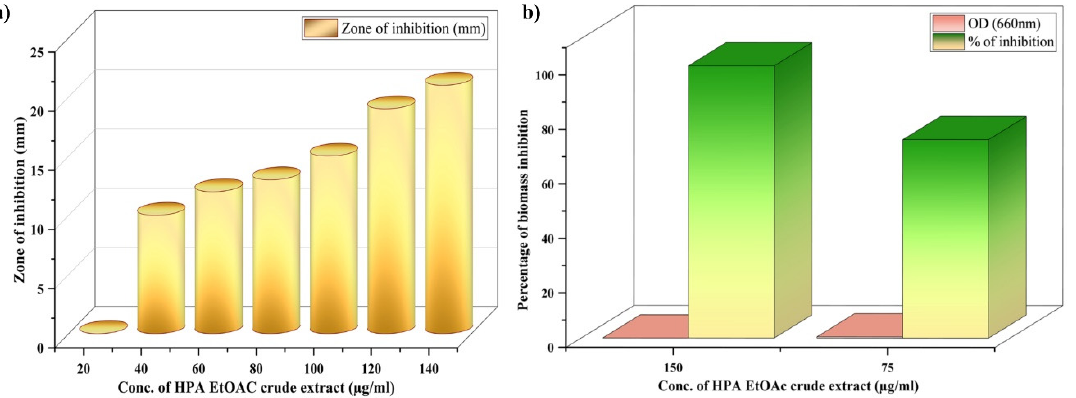
Figure 1. ( a ) Antibacterial activity of halophilic P. aeruginosa derived EtOAc (HPA EtOAc) crude extract in zone of inhibition (mm in diameter) against methicillin-resistant Staphylococcus aureus (MRSA); ( b ) microbial biomass inhibition efficiency of HPA EtOAc crude extract at 75 and 150 µg/mL concentrations on MRSA.